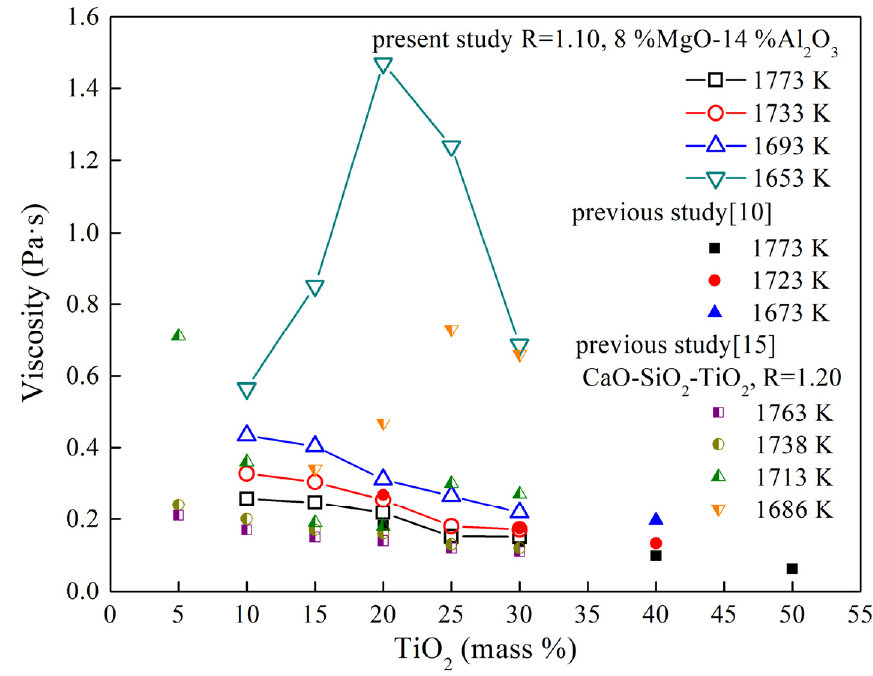
Figure 2. Viscosity of the CaO-SiO 2 -8 mass% MgO-14 mass% Al 2 O 3 -TiO 2 (R = 1.10) slag as a function of mass% TiO 2 .